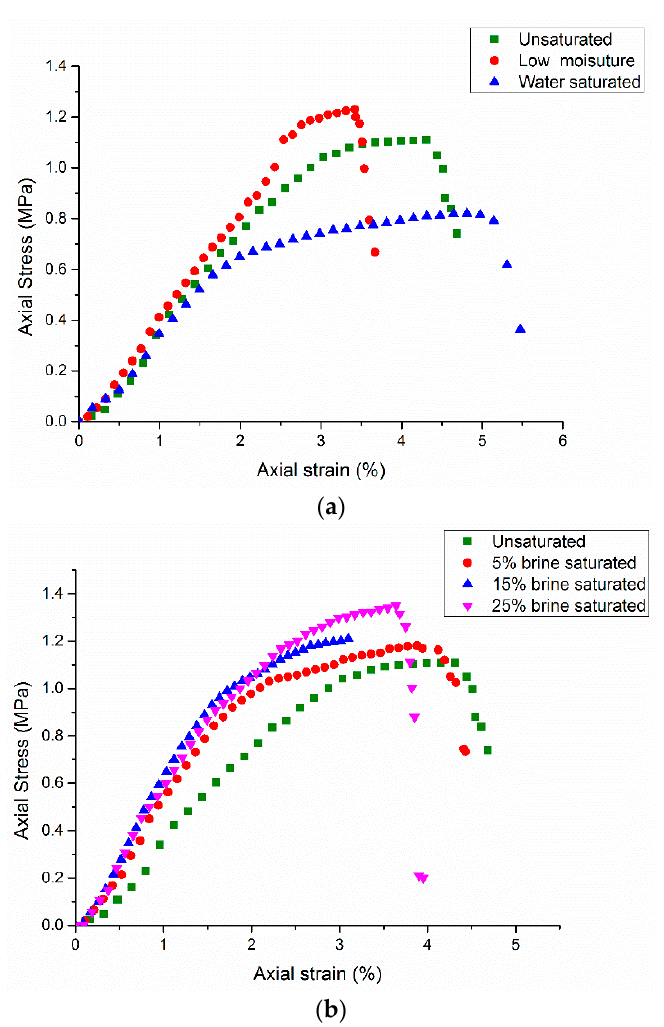
Figure 2. Axial stress versus strain curves of ( a ) unsaturated sample, low moisture content sample and water saturated sample; ( b ) unsaturated sample, 5%, 15%, 25% brine saturated sample.